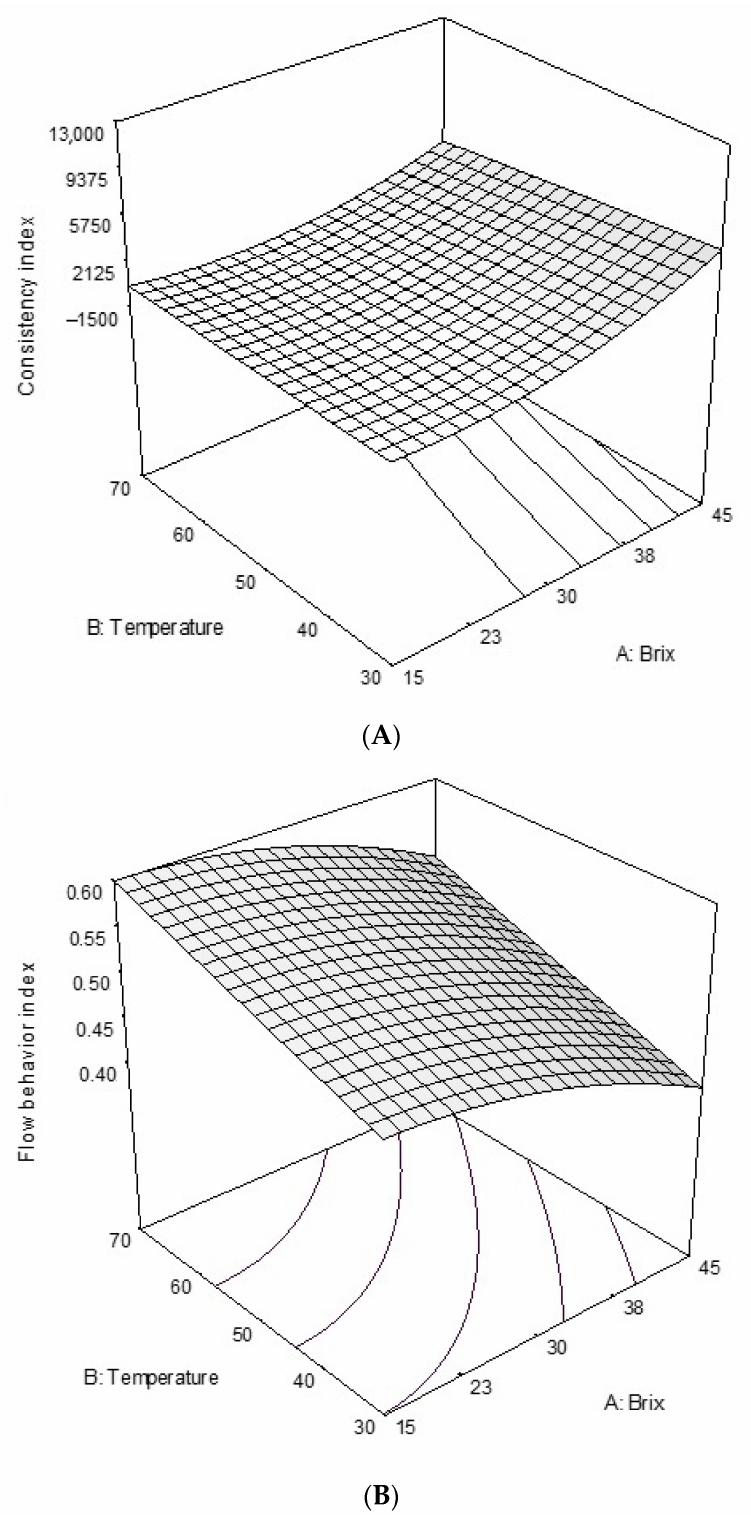
Figure 2. ( A ) The e ff ects of temperature and degrees Brix on the consistency index (cP) of licorice solutions at shear rate of 50 sec − 1 and ( B ) The e ff ects of temperature and degrees Brix on the flow behavior index of licorice extract